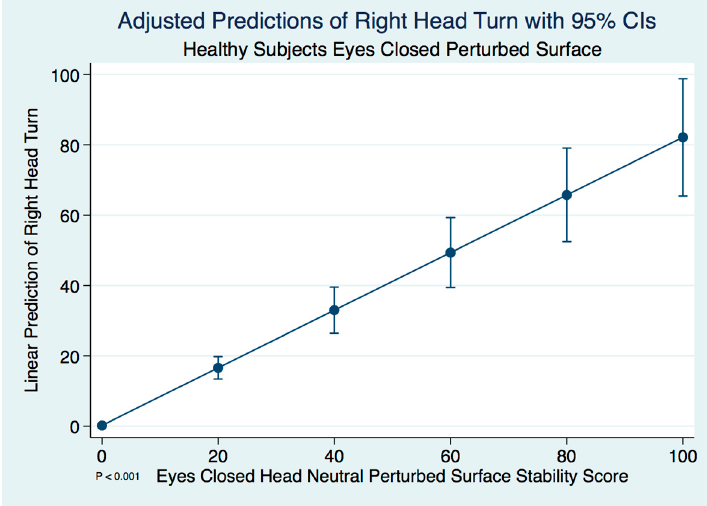
Figure 2. Adjusted predictions of right head turn stability scores in healthy normal controls.